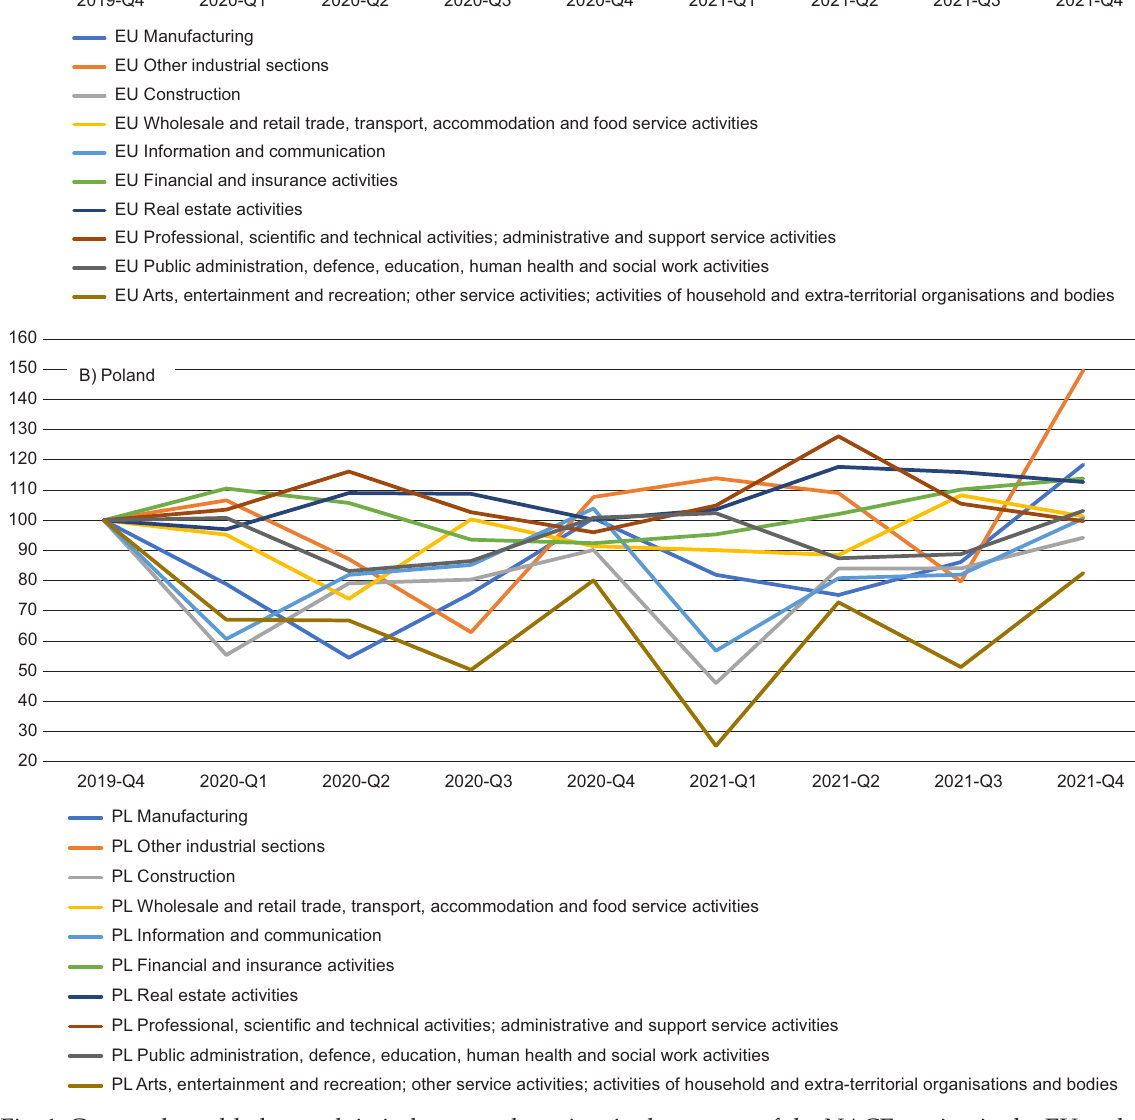
Fig. 1. Gross value added growth in industry and services in the groups of the NACE section in the EU and Poland (2019–Q4 = 100%). Source: own study based on Eurostat